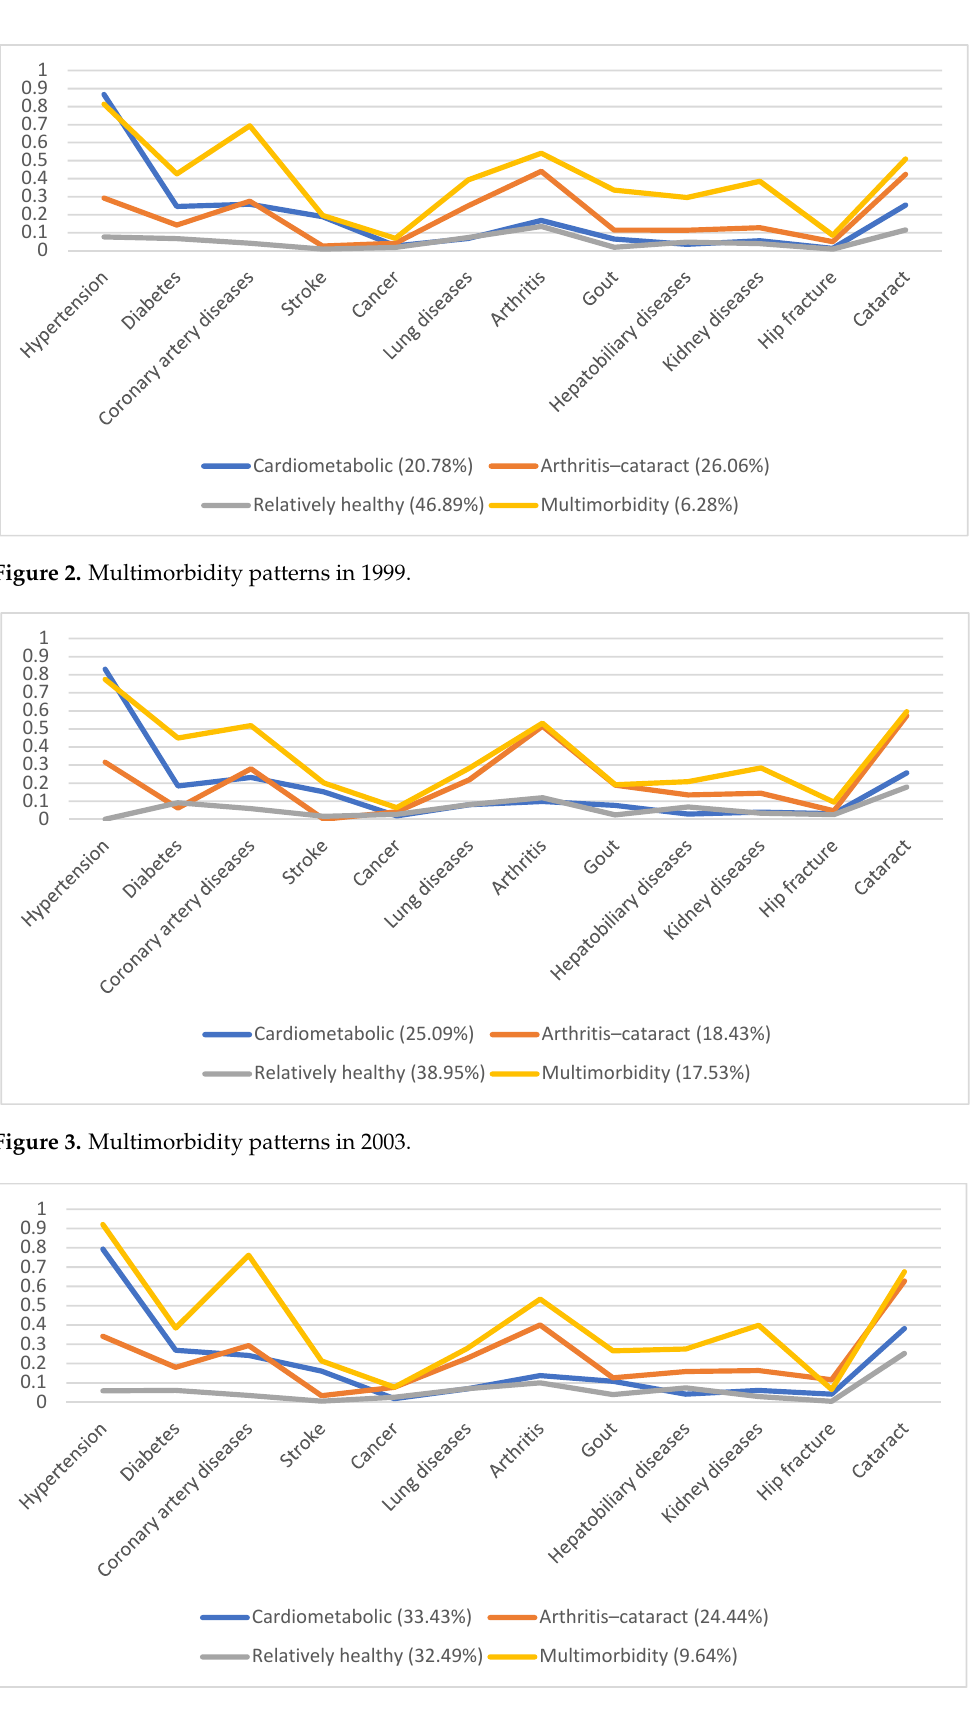
Figure 4. Multimorbidity patterns in 2007.